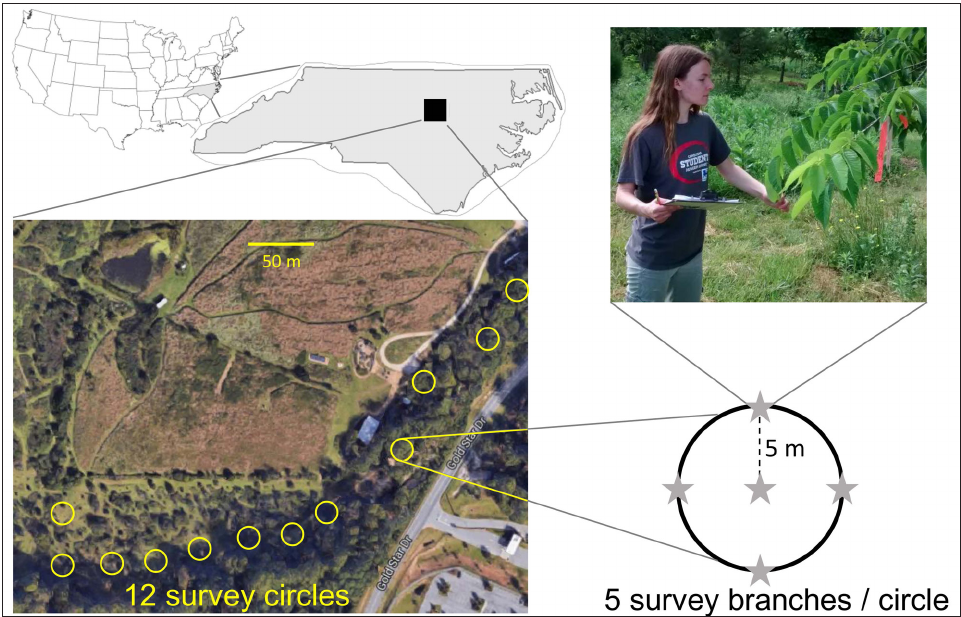
Figure 1: Location of Prairie Ridge Ecostation within North Carolina, and the layout of survey circles at that site. Each survey circle consists of five foliage arthropod surveys. Photo credits: Google Earth; Allen